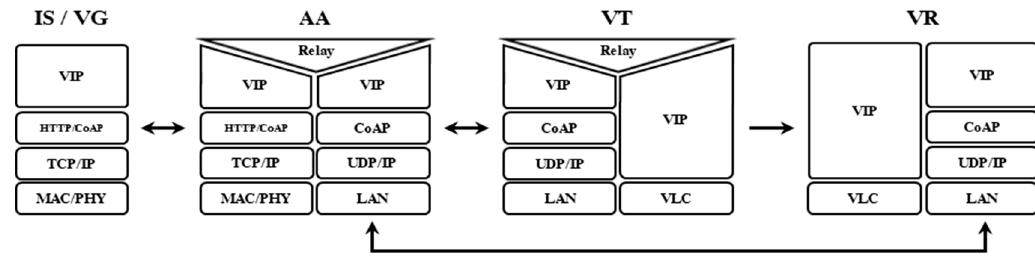
Figure 4. Protocol stacks used for VIP.